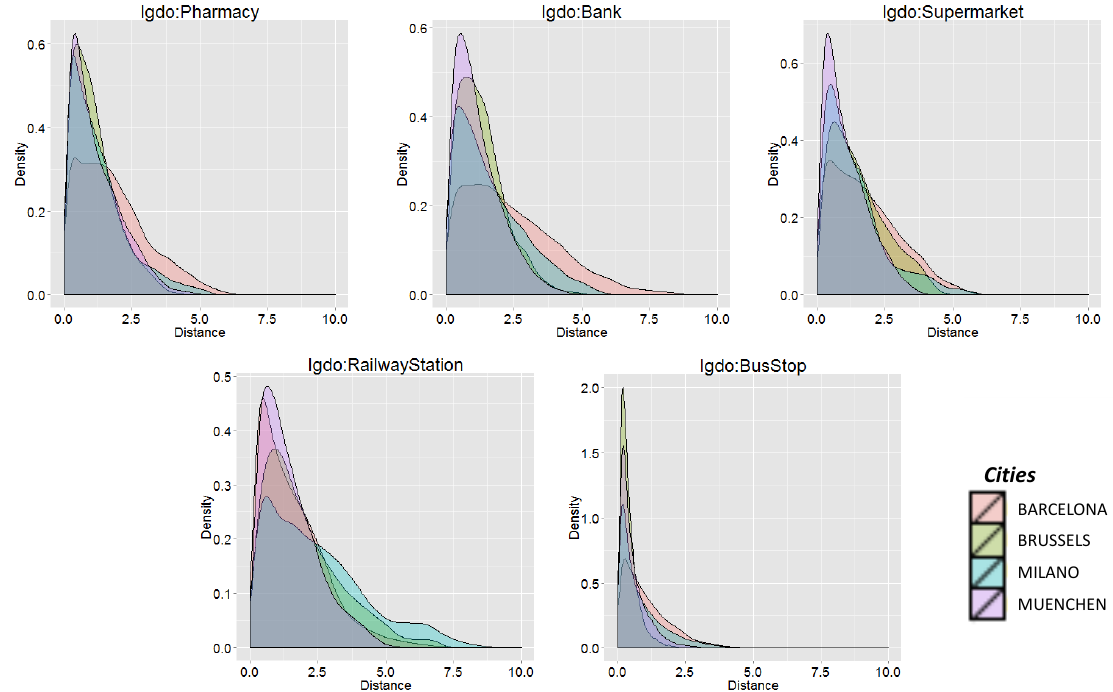
Figure 3. Distribution in the four cities of the five top-ranked predictors, according to their information gain.